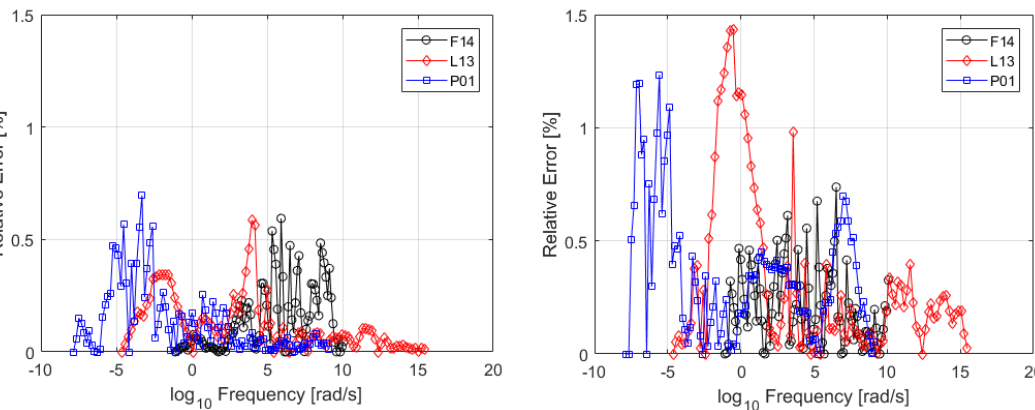
Figure 6. Storage ( left chart ) and loss ( right chart ) moduli relative error for three rubber compounds. The same dataset was used for assessing the quality of the fit using the LBEM ap- proach. The MATLAB function “lsqnonlin” with the default trust-region-reflective fitting